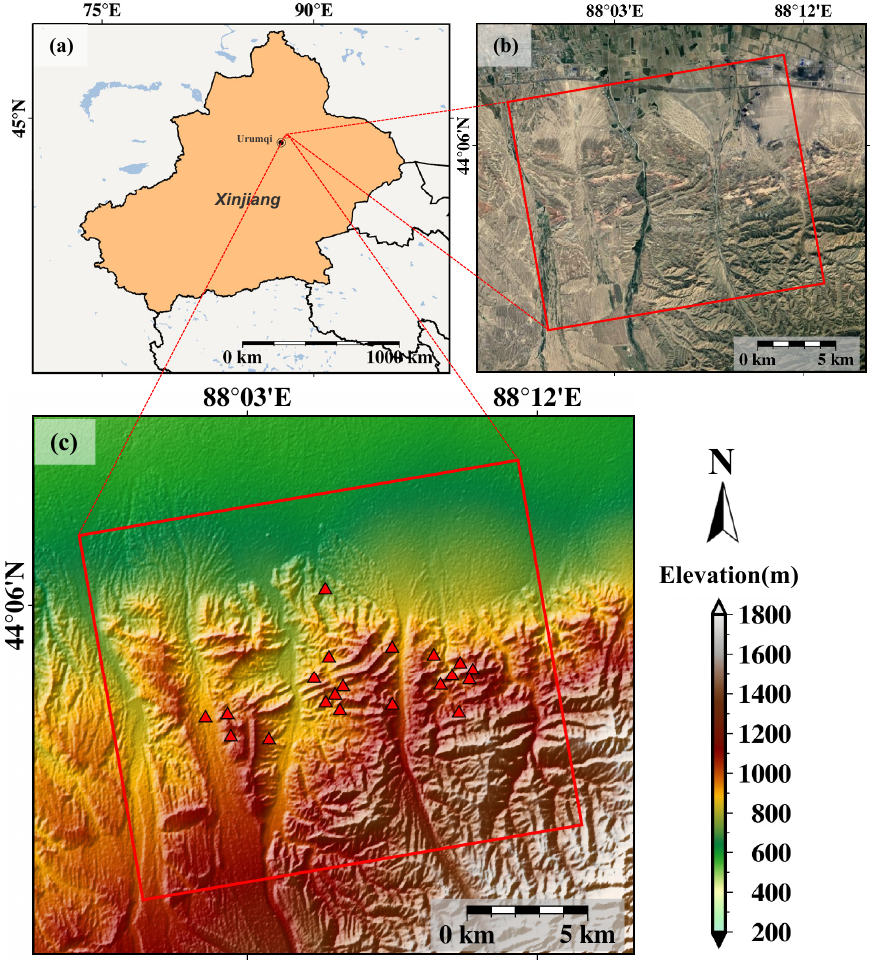
Figure 1. Sketch map of the study area. ( a ) Shows the geographical location of study area, ( b ) is optical image and ( c ) is DEM over the study area derived from SRTM data. The red box indicates the detection range of ground deformation in ( b , c ). The red triangles in ( c ) represent the detected coal fire